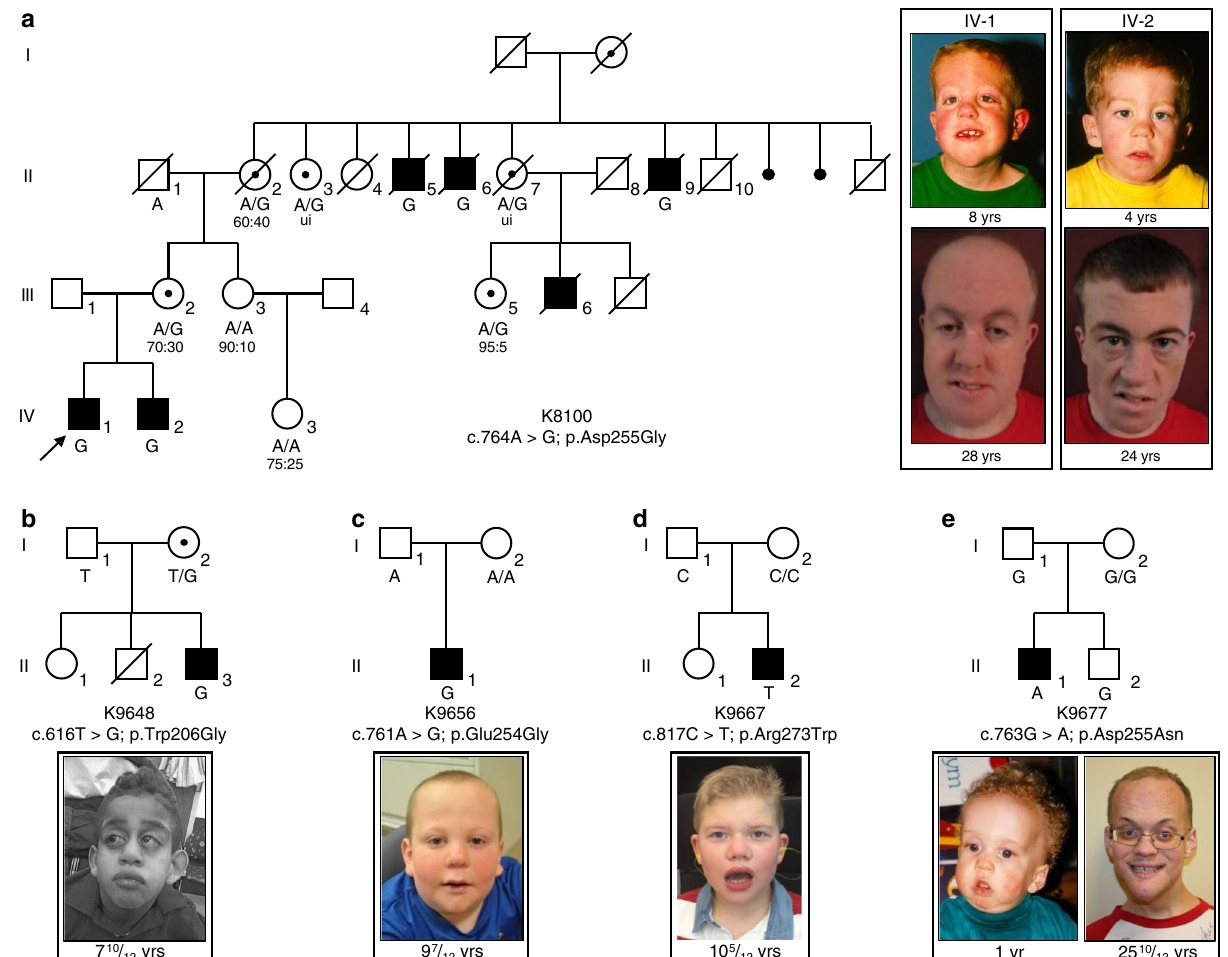
Fig. 1 Missense variants in FAM50A cause XLID in fi ve unrelated families. a – e Pedigrees of the fi ve families reported in this study are shown, with FAM50A genotype given for each available individual. Photographs of available affected males are provided for each pedigree. For family K8100, photographs are provided for the two affected males in generation IV at ages 8 and 4 years, when the family was originally published 4 ; new photos from the last clinical assessment (December 2017) are shown (28 and 24 years). Ratios under females II-2, III-2, III-3, III-5, and IV-3 represent X-inactivation data. Females II-3 and II-7 were uninformative (ui) at the AR locus. Circles, females; squares, males; un fi lled shapes, unaffected; black fi lled shapes, affected; unshaded circle with black dot, carrier female as determined by FAM50A analysis or by pedigree structure; diagonal line, deceased. Male K8100- III-6 had macrocephaly, seizure disorder, bilateral ventricular enlargement, and atrophy of the left hemisphere on a pneumoencephalogram; he was unavailable for FAM50A servers also indicate that the Arg273Trp variant might destabilize the protein (Supplementary Table 2).